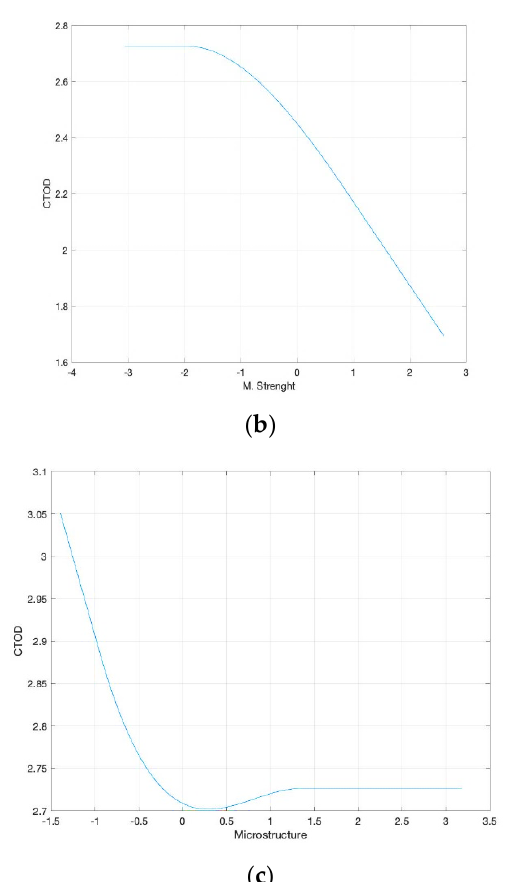
Figure 5. ( a ) Multivariate adaptive regression splines (MARS) model plot for two of the explanatory variables together with its knot locations (up) and ( b ) the analysis of variance (ANOVA) function for the pairs CTOD-M. Strength (left) and ( c ) CTOD-microstructure (right) (using ARESLab toolbox: Jekabsons G., ARESLab: Adaptive Regression Splines Toolbox for Matlab/Octave, 2016, available at http://www.cs.rtu.lv/jekabsons/).